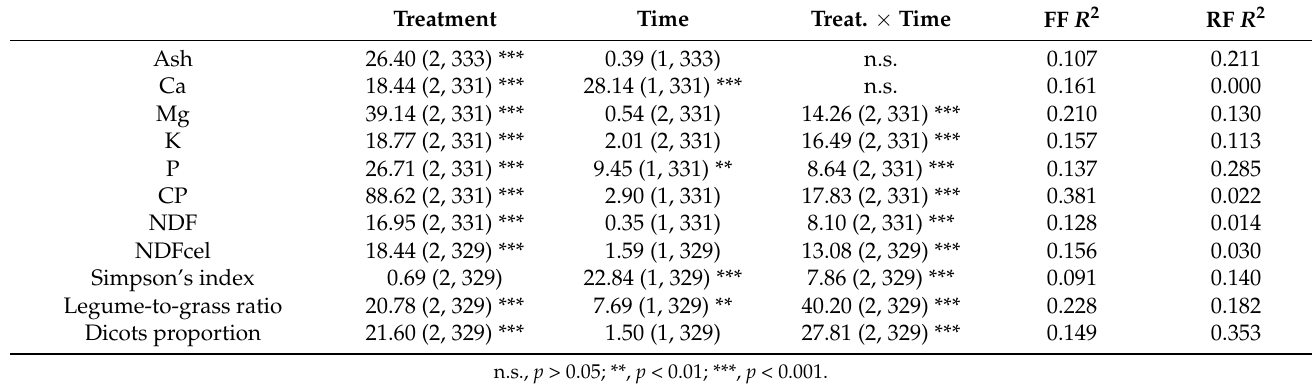
Table 1. Hypothesis testing results, after linear mixed modelling, for eight forage quality properties and three derived floristic composition variables measured in a repeated-measurements (2005–2010) RCB experiment, implemented to simulate the effects of grazing exclusion on forage quality. Columns 2–4 report F -values, together with degrees of freedom (among parentheses); p -values are indicated with asterisks. Degrees of freedom differ among variables because, in some cases, there are missing values. Parameter estimation is reported in Table 2 and illustrated in Figures 2 and 3, Figures S3 and S4. FF = Fixed Factors; RF = Random Factor.